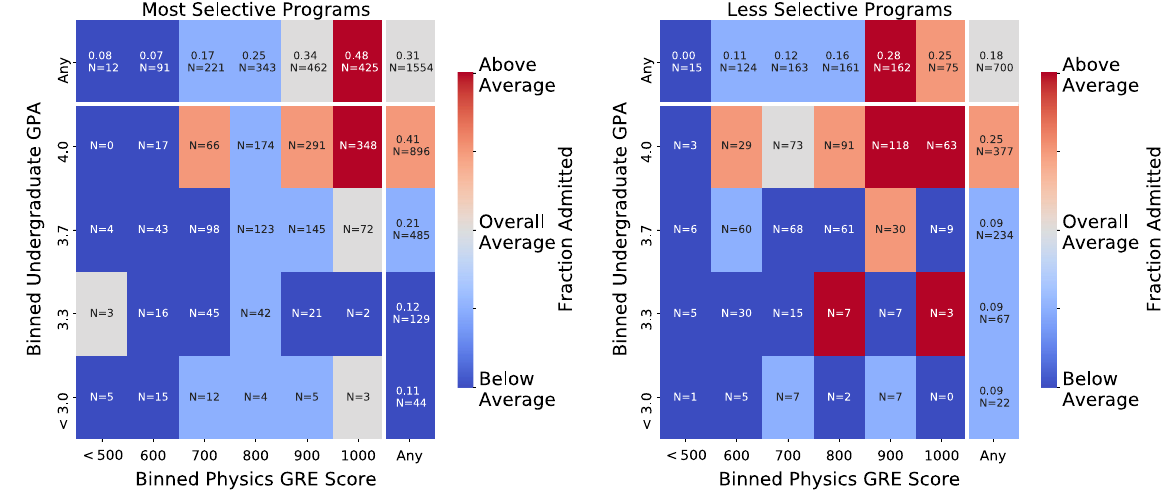
FIG. 6. Fraction of applicants admitted by undergraduate GPA and physics GRE score and split by selective or nonselective undergraduate university.